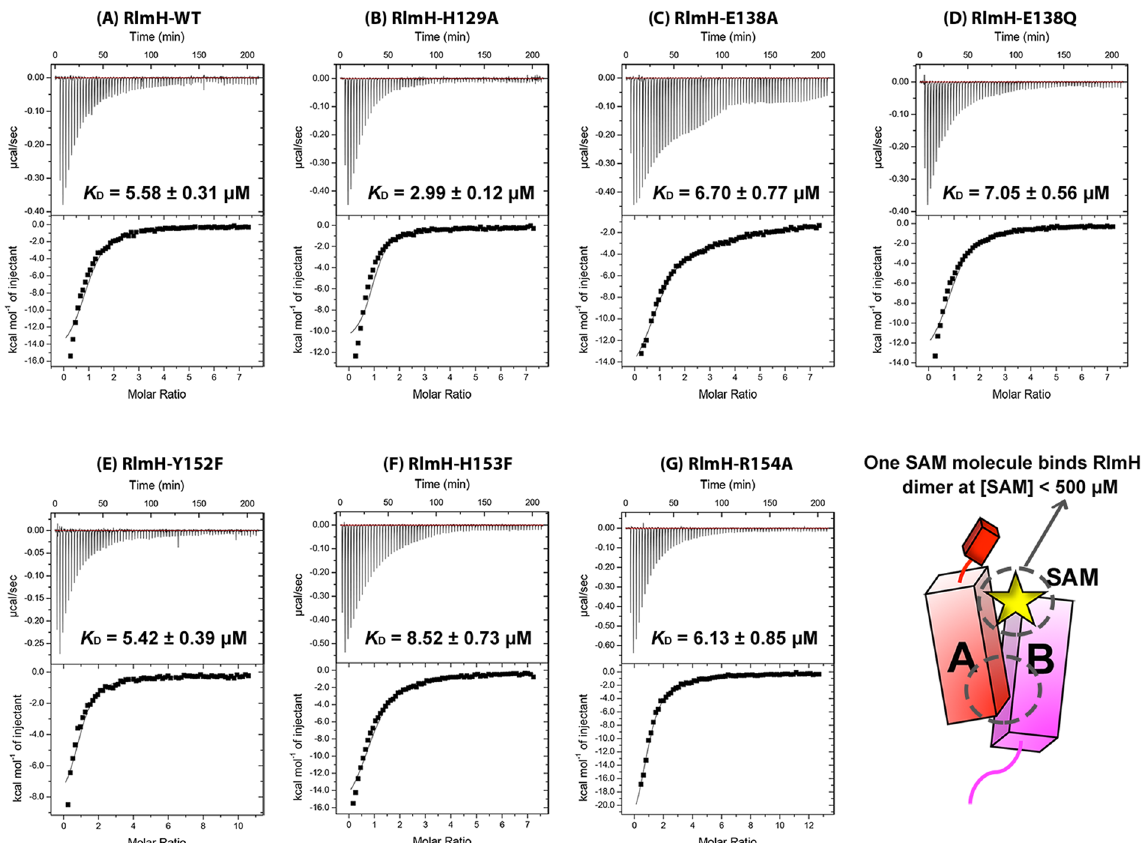
Figure 3. ITC analyses of SAM binding to wild-type or mutant RlmH. ( A ) 50 µ M RlmH wild-type; (B) 51 µ M RlmH-H129A; (C) 50 µ M RlmH-E138A; (D) 51 µ M RlmH-E138Q; (E) 35 µ M RlmH-Y152F; (F) 51 µ M RlmH- H153F and (G) 29 µ M RlmH-R154A. Dissociation constants ( K D ) of SAM for each RlmH mutant are calculated from three replicates (except R154A, n = 2). Data were fitted using a sequential binding model. The c-value was 10. See also Figure S7.